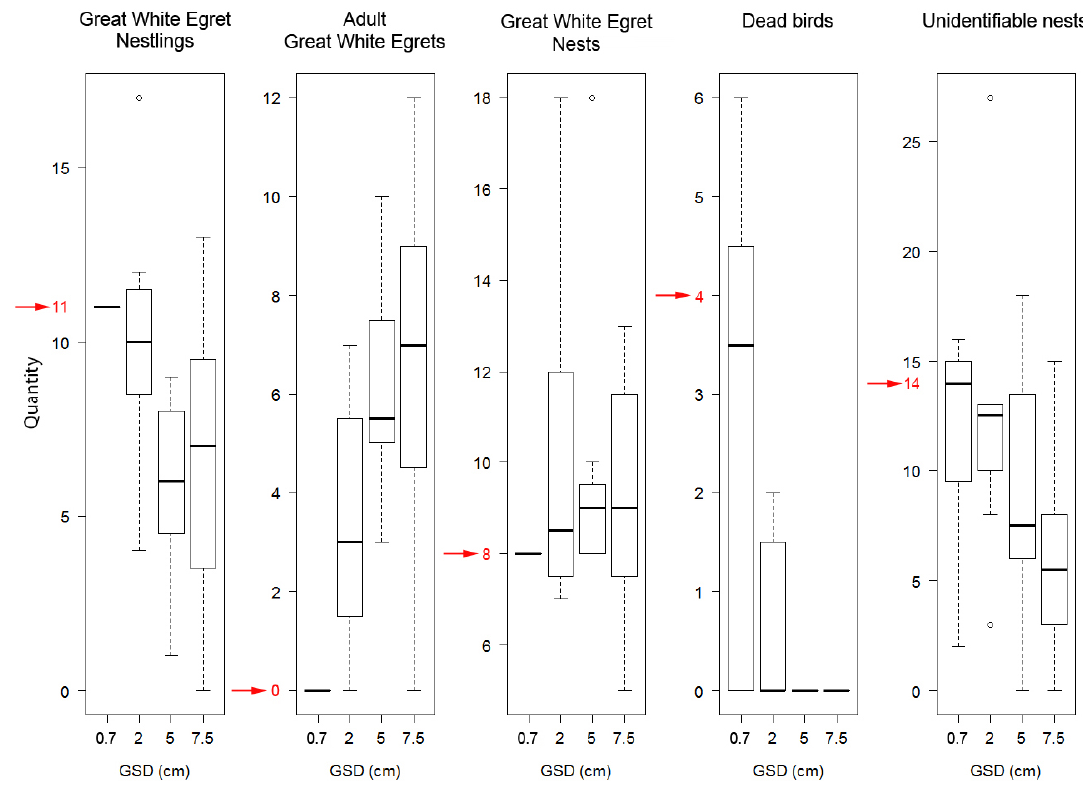
Figure 12. Deviation of the analysis of 8 interpreters, depending on the spatial resolution. Orthophotos with 0.7 cm spatial resolution were already sufficiently reliable to analyze the number of herons and heron nestlings. The red arrow indicates the values experienced in field inspection.